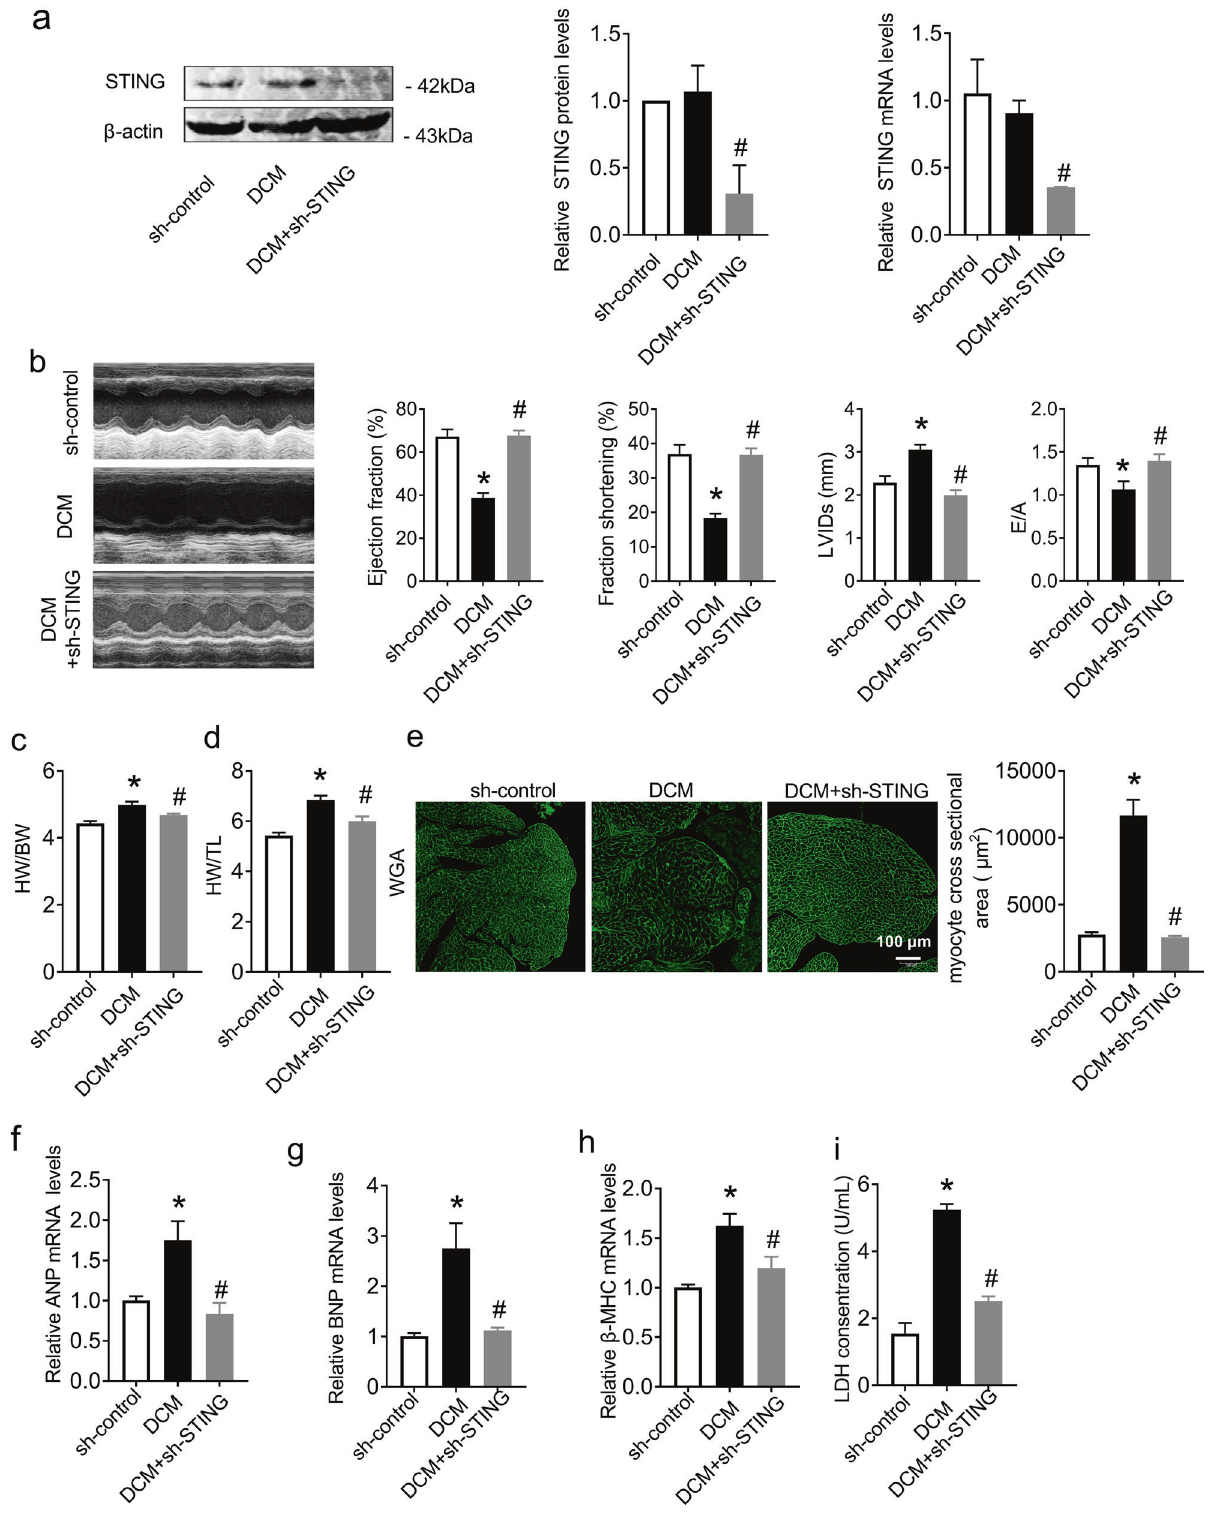
Fig. 2 Knockdown of STING signi fi cantly improved cardiac function and inhibited cardiac hypertrophy in DCM mice. a Protein and mRNA levels of STING normalized to β -actin in heart tissues. n = 3 in each group. b Transthoracic echocardiography was performed to observe changes in cardiac function and morphology in both sh-control and DCM animals with or without shRNA of STING. Statistics of ejection fraction, fractional shortening, LVIDs and peak E to peak A (E/A) ratio. n = 7 in each group. c , d Statistical results of heart weight/body weight (HW/BW) and heart weight/tibia length (HW/TL). n = 6 in each group. e Quantitative analysis of myocyte cross-sectional area by WGA staining. n = 3 in each group. f – h mRNA levels of ANP, BNP, and β -MHC in heart tissues. n = 3 in each group. i LDH release in each group. n = 6 in each group. Values are the mean ± SEM. * P < 0.05 vs. the sh-control group, # P < 0.05 vs. the DCM group. DCM diabetic cardiomyopathy, sh-STING shRNA of STING.